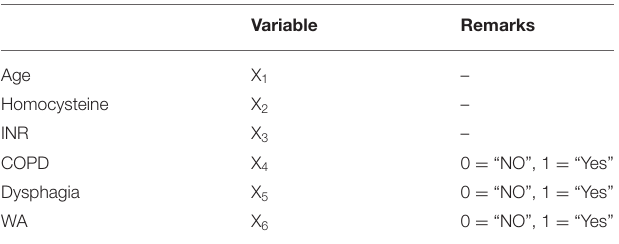
TABLE 4 | Variable assignments.